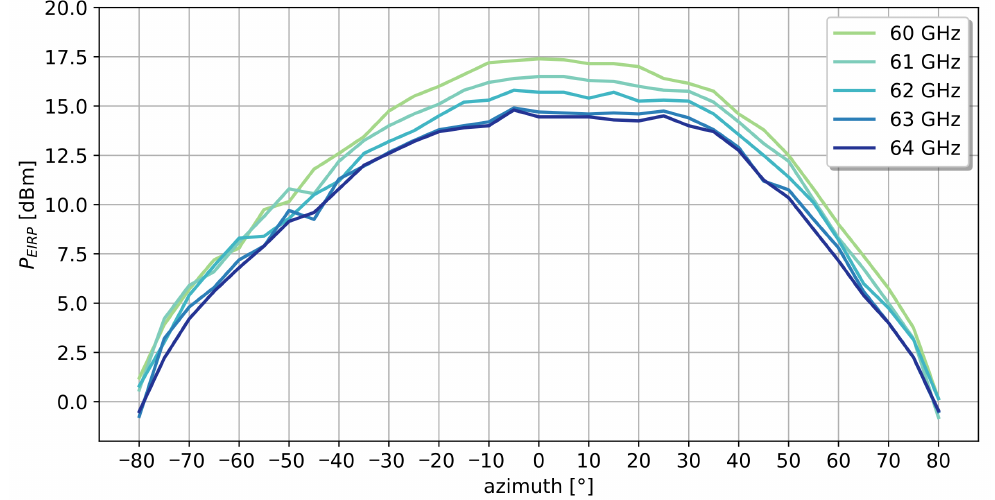
Figure 8. The approximate radiation pattern of TX2 transmitting antenna over azimuth at the best elevation